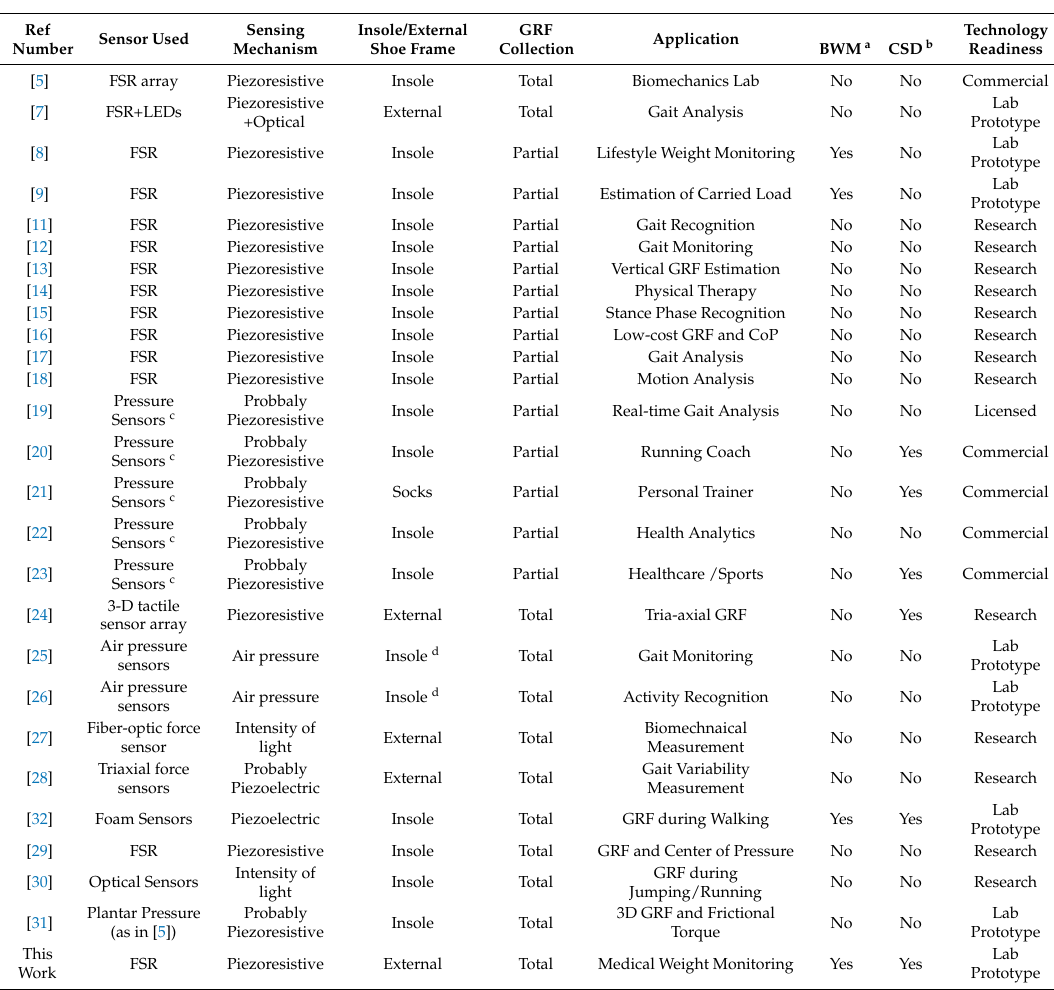
Table 2. Summary of Prior